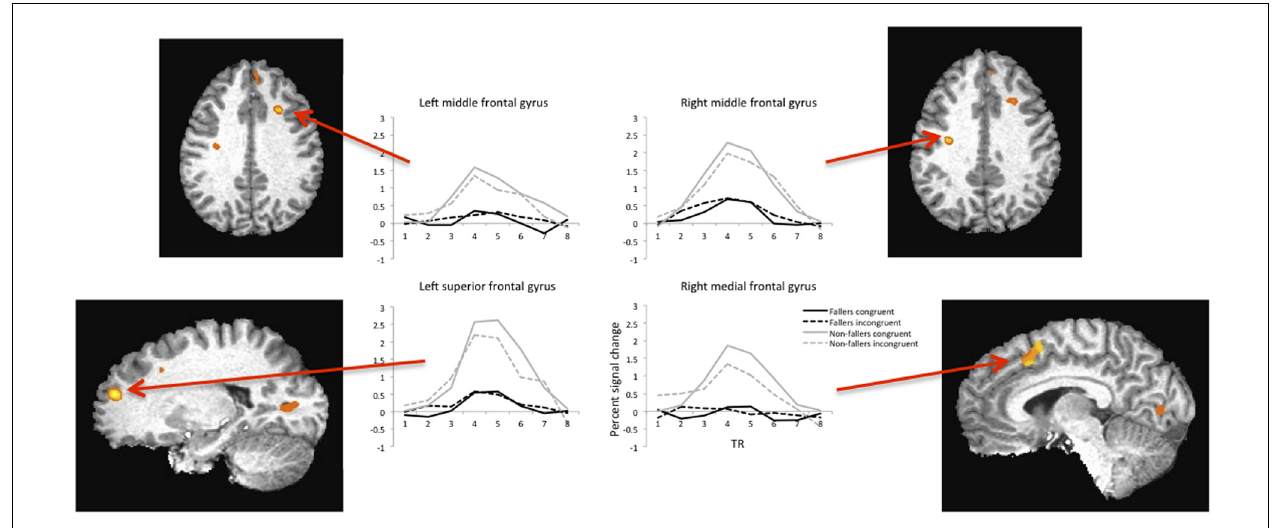
FIGURE 2 | Example hemodynamic responses during fMRI for four regions of interest plotted as a function of condition type (congruent versus incongruent) and group (fallers versus non-fallers). Each region listed showed significantly higher activity in the non-fallers for the congruent condition. Note: images are shown in radiologic space (L =